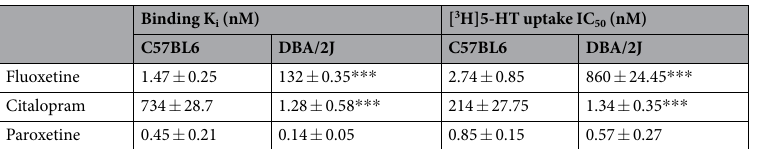
in the brains of the two strains of mice, as SSRIs bind the 5-HT transporter, leading to elevation of monoamines and antidepressant effects 9, 15, 24 . We found that paroxetine demonstrated equivalent high affinity for SERT in the two strains of mice. Fluoxetine demonstrated high affinity for SERT in C57BL/6J mice, which was 100-fold higher